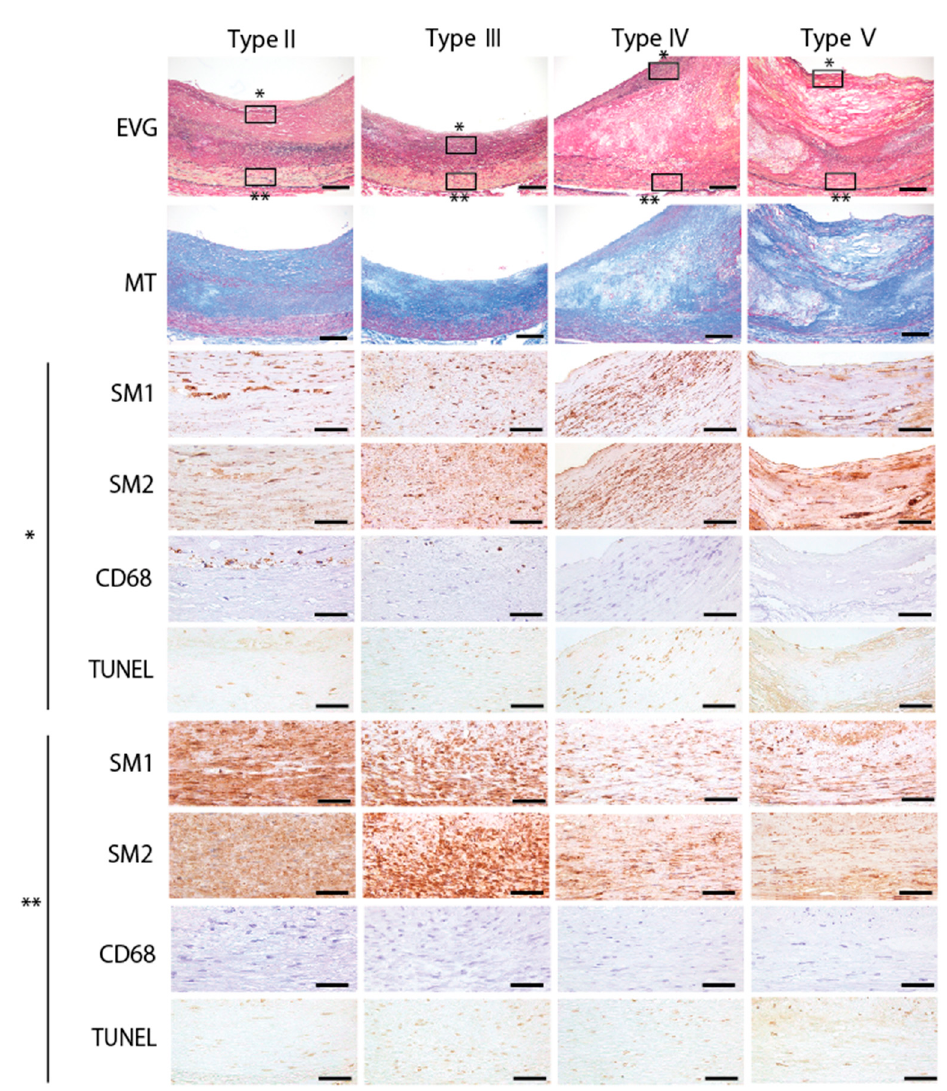
Figure 4. Histological analysis of human coronary arteries. Representative images of EVG (Elastica van Gieson staining), MT (Masson’s trichrome staining), and immunohistochemistry for CD68 (a marker of macrophages), SM1 and SM2 (myosin heavy chain 11 isoforms), and TUNEL (TdT-mediated dUTP Nick End Labeling) stain in Type II (patient 4), Type III (patient 1), Type IV (patient 3), and Type V (patient 3) atherosclerotic lesions. * Magnified images of black boxes in the intimal layer. ** Magnified images of black boxes in the medial layer. Scale bars for EVG and MT: 200 μ m. Scale bars for immunohistochemistry and TUNEL stain: 50 μ m.